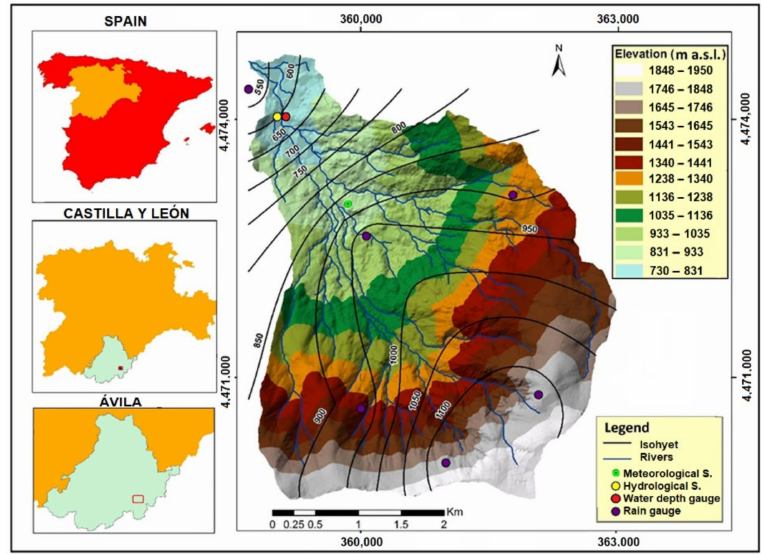
Figure 5. Venero Claro mountain basin and its monitoring